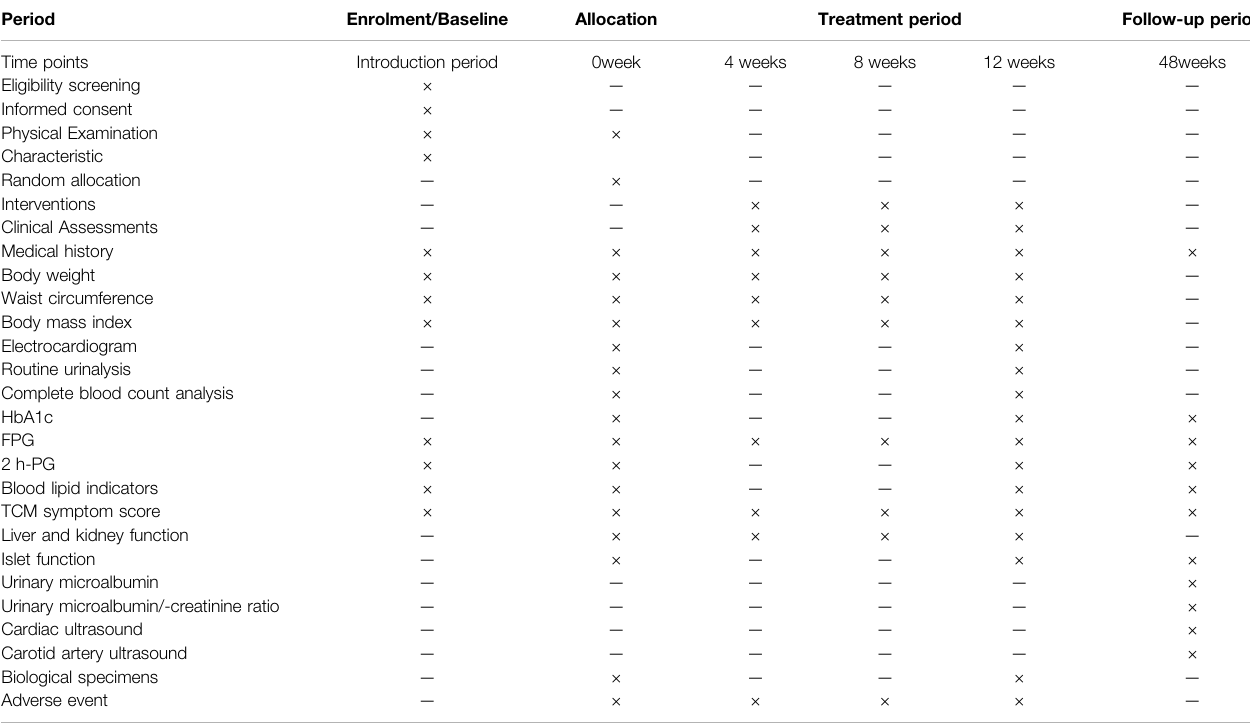
TABLE 1 | Schedule of enrolment, assessments, and data